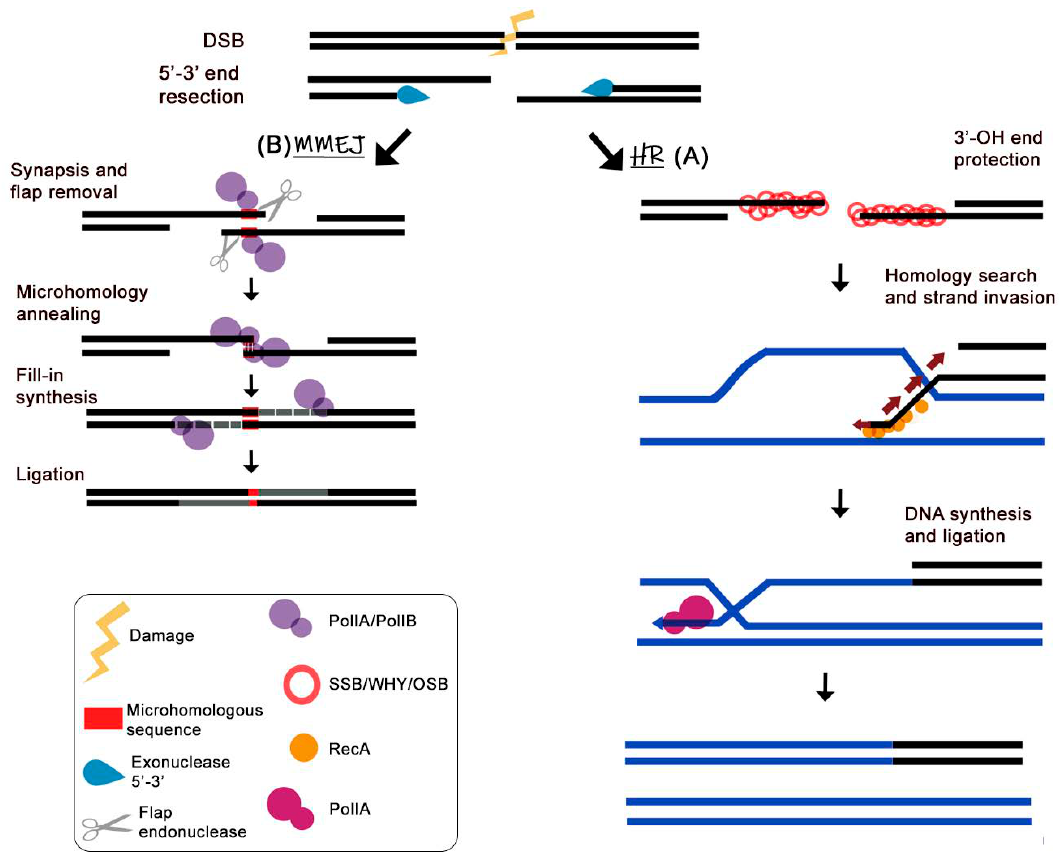
Figure 5. Plant mitochondria employ di ff erent mechanisms to repair DSBs. ( A ) DNA repair by HR. Repair of double-strand breaks is initiated by resection enzymes that generate a 3 (cid:48) -OH end. The length of the 3 (cid:48) OH end can be long or short. In plant mitochondria, a long 3 (cid:48) -OH (right panel) is protected by single-stranded binding proteins like SSBs, WHY, or OSBs. AtRECAs, with the help of accessory proteins, displace the single-stranded binding proteins and initiate the search for homologous sequences. After the strand invasion, DNA synthesis is initiated by an organellar DNA polymerase. Finally, a ligation step is necessary to seal the break. ( B ) DNA repair by MMEJ. In short 3 (cid:48) -OH (left panel) that contain micro-homologous sequences, DNA polymerase anneals two strands by trans complementation. This mechanism is known as MMEJ. These short sequences require a minimum of two base pairs to bind and extend them by the same DNA polymerase. In the organelles of A. thaliana, MMEJ is executed by AtPOLIA and